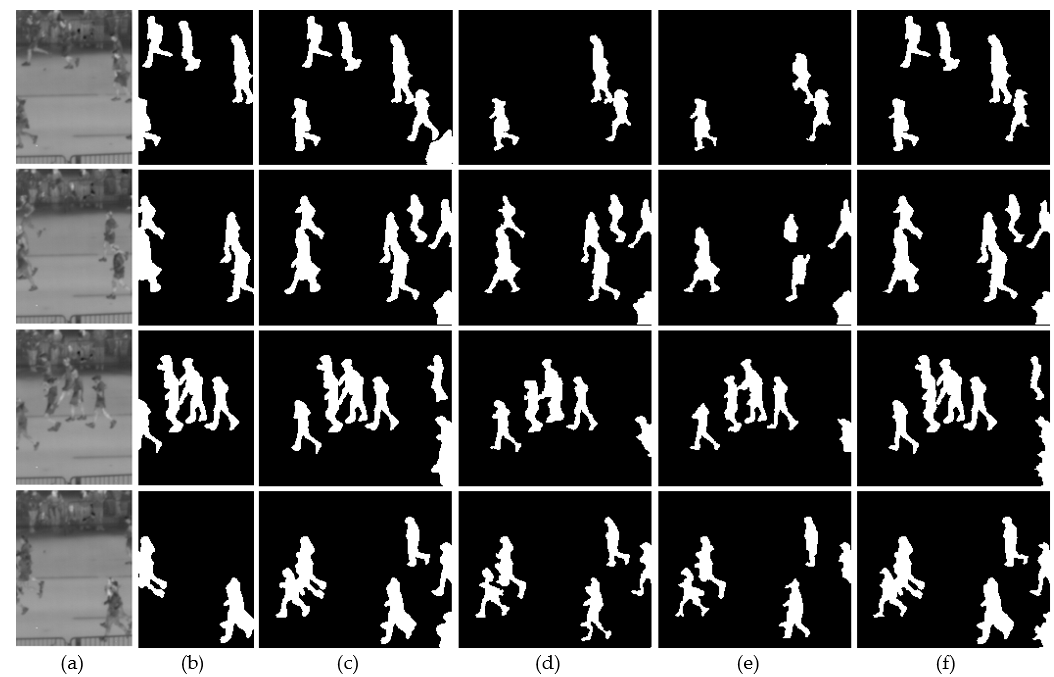
Figure 14. Comparisons of detection results using original images, GT images, and the predicted images obtained by the state-of-the-art methods and the proposed method: ( a ) original images; detection results using ( b ) original images and ( c ) GT images of Figures 11b–13b; and the images predicted by ( d ) Haziq et al. [26], ( e ) Liu et al. [17], and ( f ) the proposed method.